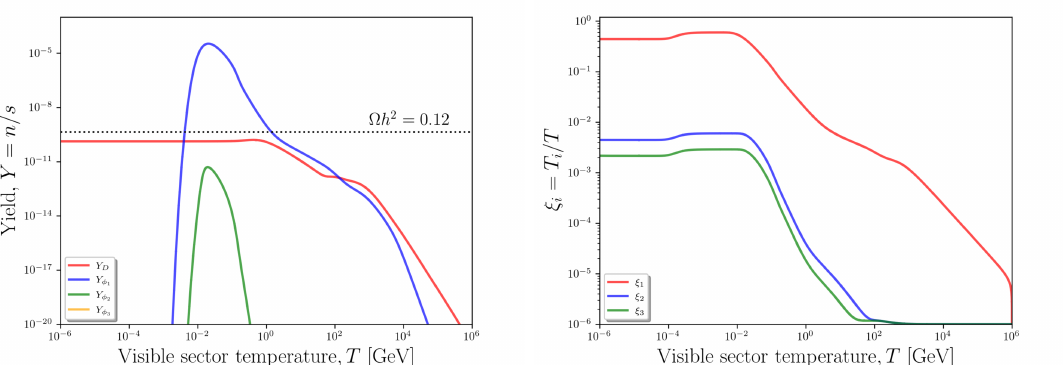
Figure 4. Same input as in figure 2 but for y f = 1 × 10 − 10 . Relic density Ω h 2 Ω h 2 = Ω h 2 ∼ 0 φ 2 φ 3